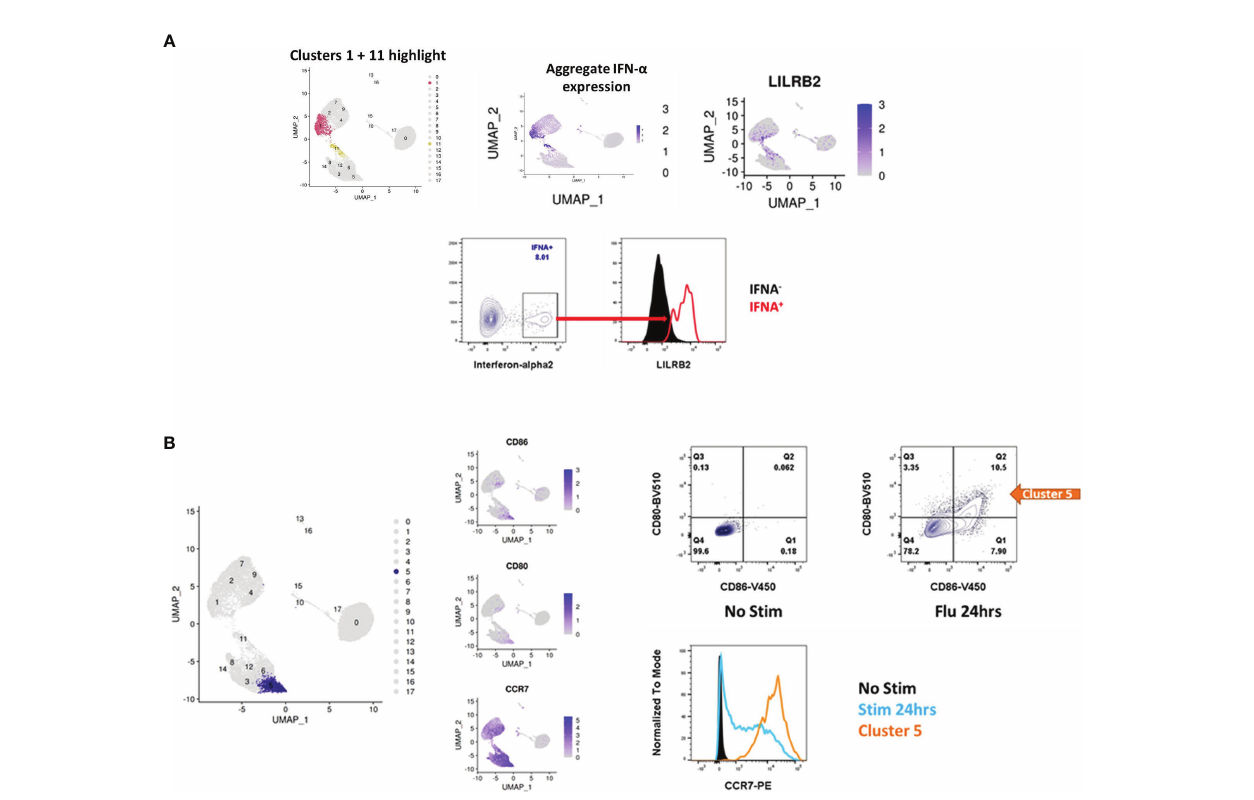
FIGURE 8 | Validation of surface markers suggested by scRNA-seq. (A) pDCs in the IFN- a + cluster lose canonical pDC markers and adopt new ones (see also, Figure 4 ), including IL18RAP, LILRA5 and LILRB2. Upon stimulation with in fl uenza virus, the population of IFN- a + cells stains positive for LILRB2 whereas IFN- a - cells are negative for LILRB2. (B) Cluster 5 is notable for the adoption of a cDC like state, including upregulation of ID2 ( Figure 5 ), CD80, CD86 and CCR7. Stimulation of pDCs with in fl uenza virus produces a population of cells which stain for CD80 and CD86, these cells also upregulate expression of CCR7 at the protein level as determined by fl ow